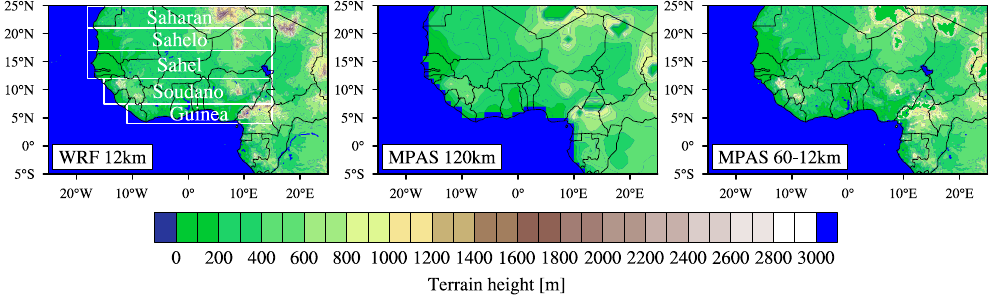
Figure 8. Model topography (terrain height in metres) for the WRF reference and the two MPAS model runs for the West African WRF domain. The left panel also indicates five distinct agro-climatical zones, following a gradient of decreasing annual precipitation from south to